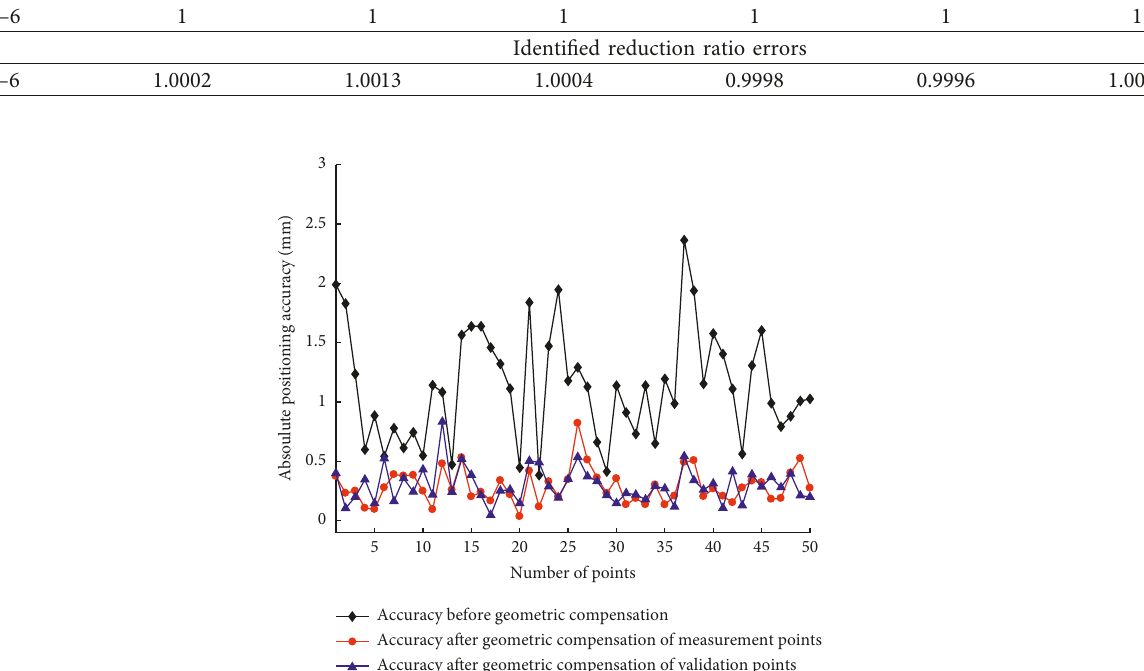
Figure 5: Positioning accuracy before and after geometric